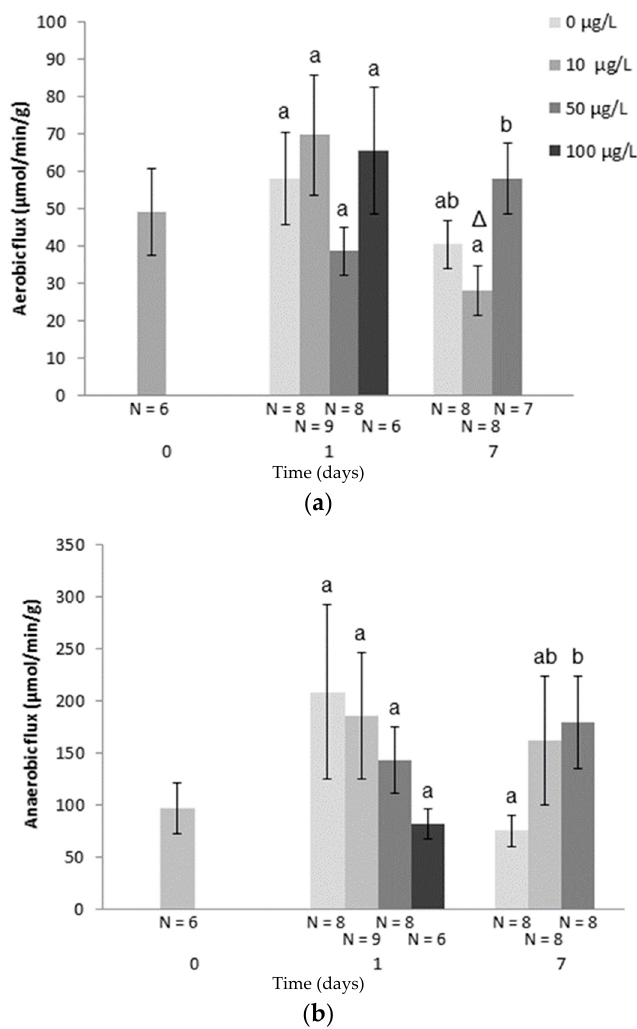
Figure 1. ( a ) Aerobic flux (µmol/min/g) and ( b ) anaerobic flux (µmol/min/g) in white muscle of juvenile roach during Cu exposure. Bars represent S.E. Different letters indicate significant differences for the same time point. Δ indicates significant differences for the same concentration among individual samples at T1 and T7.